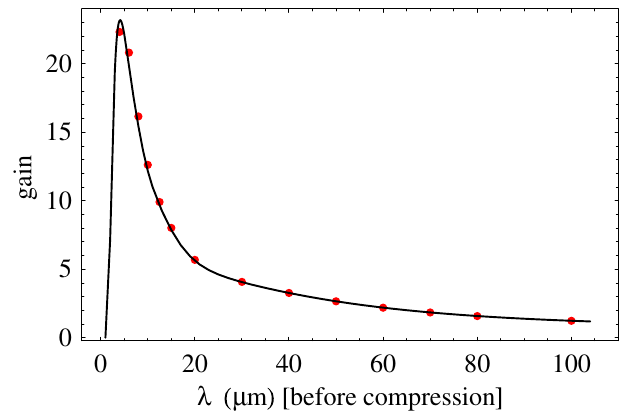
FIG. 4. (Color) Gain function through the FERMI first bunch compressor at finite current, as determined from numerical solutions of the Vlasov equation (dots) and linear theory (solid line). The peak current before compression is I (cid:1) 95 : 5 A ( I (cid:1) 336 : 2 A after compression). CSR is the only collective effect included in the calculation.